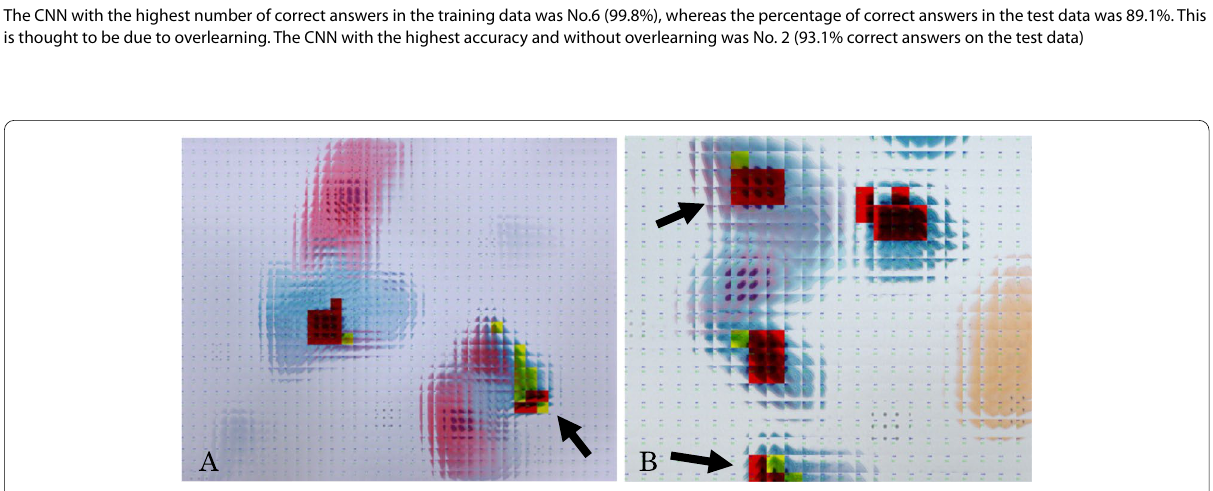
The results obtained using the SWM and convolutional neural network (CNN) methods are shown. To improve the accuracy of the loss function values and correctness of the answer rate, several dropouts were attempted to increase the number of epochs and avoid overlearning. We also deepened the network by increasing the number of convolution, pooling, and activation functions